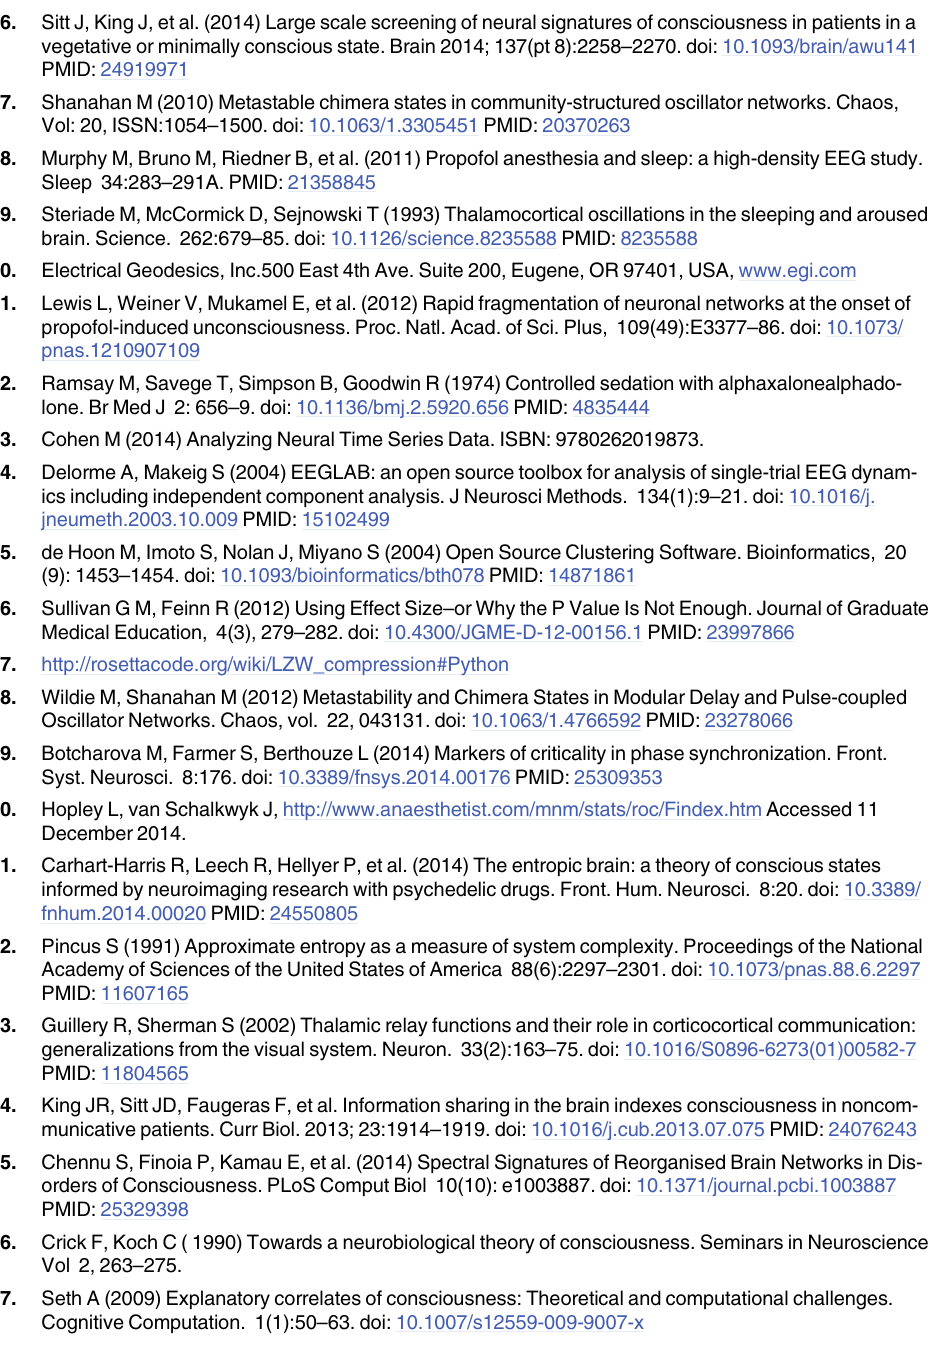
PLOS ONE | DOI:10.1371/journal.pone.0133532 August 7,